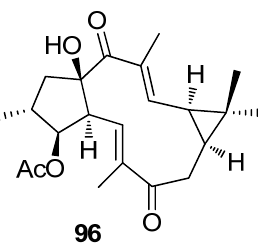
Figure 14. Structure of jatropodagin A ( 96 ).